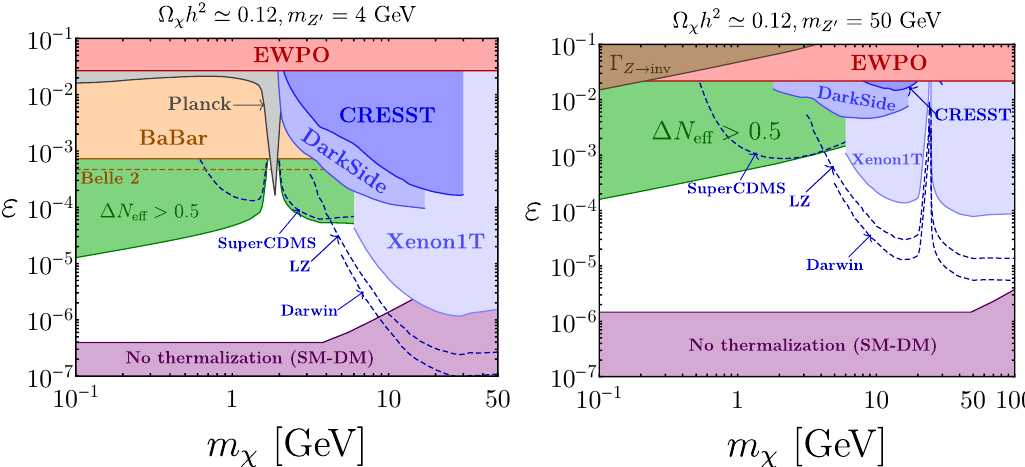
Figure 5 . Constraints on the parameter space compatible with the observed dark matter abundance and neutrino masses. Present bounds are shown in solid lines and future bounds in dashed lines. Only the region in white is allowed by current experiments and predicts (cid:1) N e(cid:11) (cid:24) 0 : 05 (cid:0) 0 : 5. Various constraints depicted in this (cid:12)gure are described in the text of section